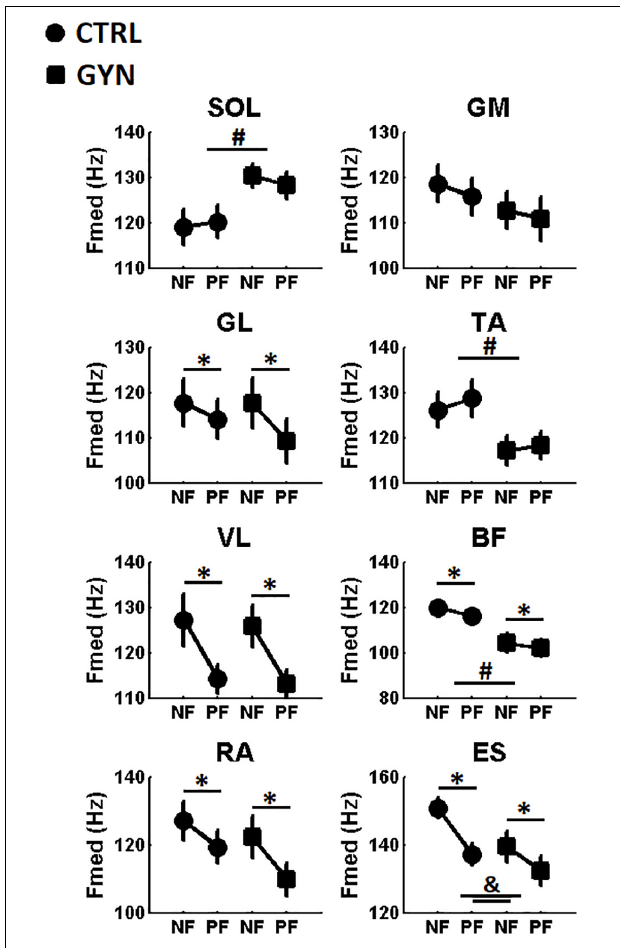
FIGURE 5 | Average Median Frequencies (Fmed, expressed in Hz) computed before (NF, no fatigue) and after (PF, post-fatigue) the fatiguing protocol. Values associated with the CTRL and GYN groups are represented by circles and squares, respectively. ∗ indicate a statistically significant effect of the fatigue factor, that is, significant differences between NF and PF ( p < 0.05). # indicate a statistically significant effect of the group factor, that is, significant differences between acrobatic gymnasts (GYN) and untrained controls (CTRL). & indicate significant interaction between “group” and “fatigue period” factor. & indicates a statically significant effect for “group” factor ( p < 0.05). TA: tibialis anterior , SOL: soleus , GL: lateral gastrocnemius , GM: